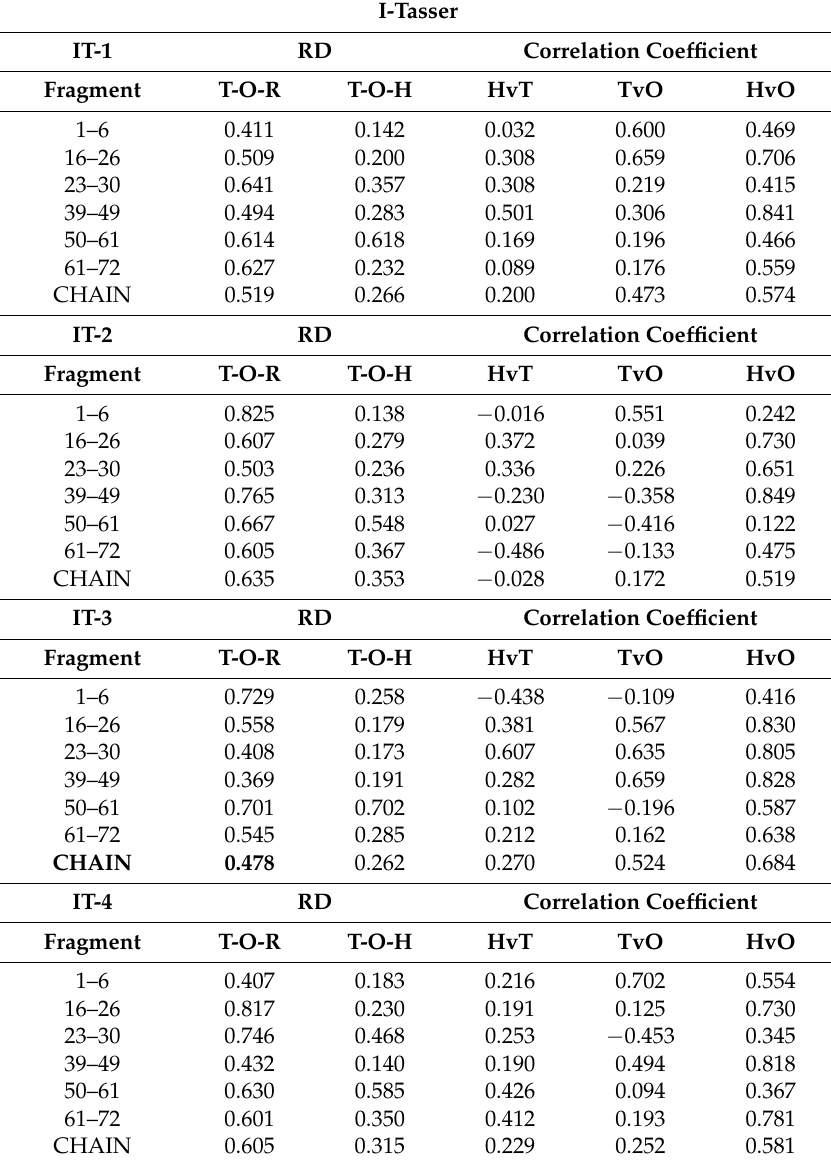
Table 5. RD values obtained using I-Tasser, Robetta and FOD. In addition to RD values (for T-O-R and T-O-H) the table also lists HvT, TvO and HvO correlation coefficients. The division into fragments is consistent with the one shown in Figure 4. Values in bold distinguish the status accordant with FOD model (RD <